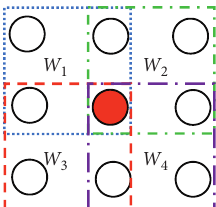
Figure 7: The relationship between pattern elements and